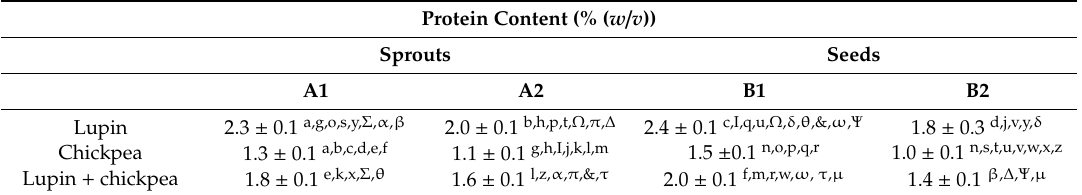
Table 2. Protein content in pulse beverages obtained from the processing procedures A and B, when included the dehulling after cooking (where the “1” corresponds to beverages with cooking water and “2” to beverages with new water). The same superscript letter / symbol in beverage-pairs evidences significant di ff erence between them ( p < 0.05). Values are represented as mean ± standard deviation.